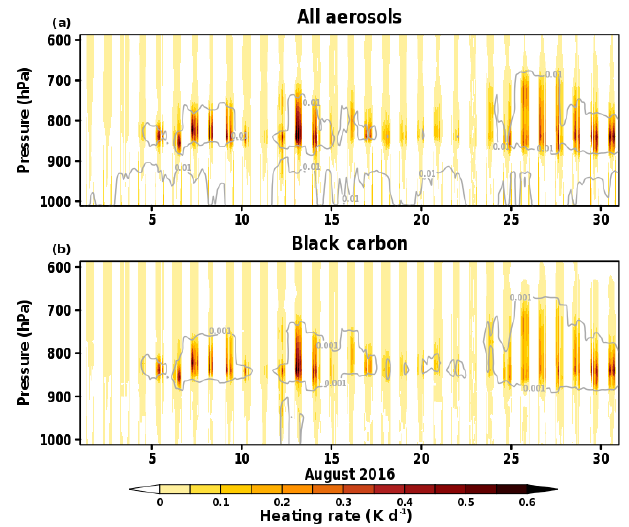
Figure 11. Enhancement of SW heating due to (a) all aerosols and (b) black carbon in the presence of clouds over Ascension Island during August 2016 using the SSA scaled by relative humidity. Gray contours indicate an AOD at 1µm of 0.01 in (a) and 0.001 in (b) .